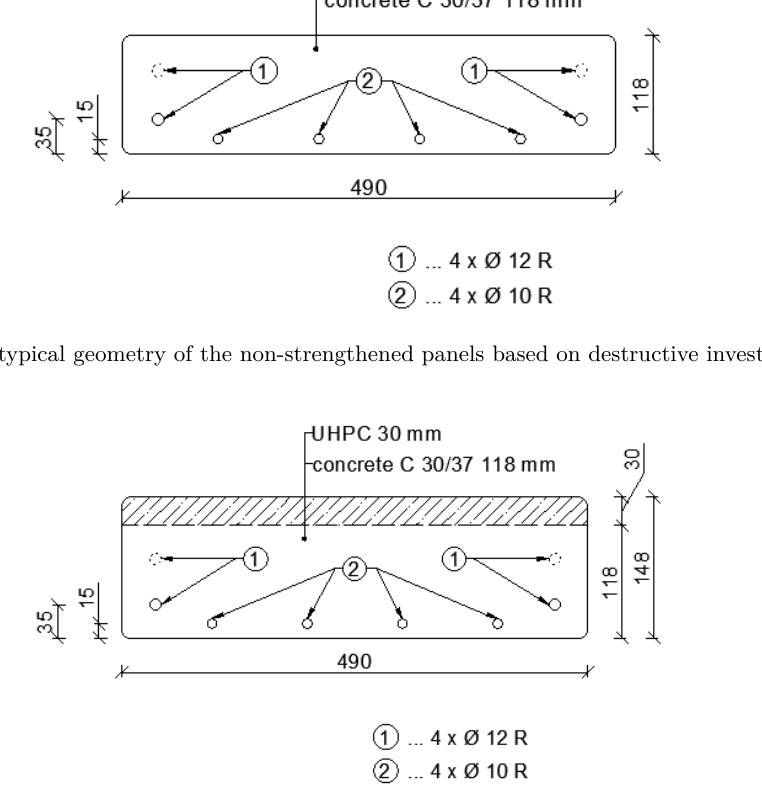
Figure 2. Typical geometry of the strengthened panels after the UHPC layer application